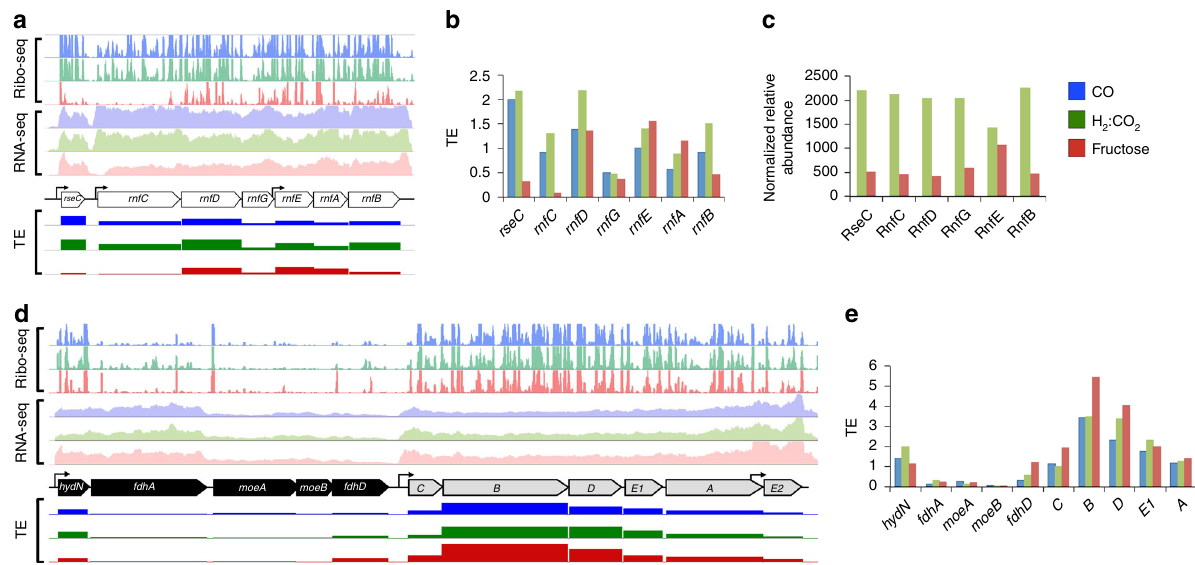
Fig. 4 Transcriptional and translational regulation of the Rnf (white), formate dehydrogenase (black), and hydrogenase (gray) complexes in all growth conditions. Results are manifested for CO, H 2 :CO 2 , and fructose in blue, green and red, respectively. a Transcription and translation of the Rnf complex (normalized to reads per million (RPM)). The rnf complex ( Clju_c11350-Clju_c11410 ) has one major TSS upstream of rnfC . The rnfEAB genes are transcribed from an internal promoter that is positioned at the 3 ′ -end of rnfG . The rseC gene is transcribed from one TSS and transcription is comparable across all conditions; however, it is poorly translated in fructose. b Comparison between TE of the Rnf genes in each condition. The rnfC gene has the lowest TE in fructose. c Shotgun proteomics showing the relative abundance of the Rnf complex proteins (RnfA was not detected) in H 2 :CO 2 and fructose. d Expression of the formate dehydrogenase and the hydrogenase genes ( Clju_c06990-Clju_c07080 , normalized to reads per million (RPM)). Both clusters are expressed from upstream TSSs. The hydN and the fdhA genes are translated at a much lower ef fi ciency compared to the hydrogenase B and D genes despite having higher transcription. e Comparison between the TE of the hydrogenase and the formate dehydrogenase genes in each condition. The hydrogenase E2 gene is transcribed at a higher level from an internal